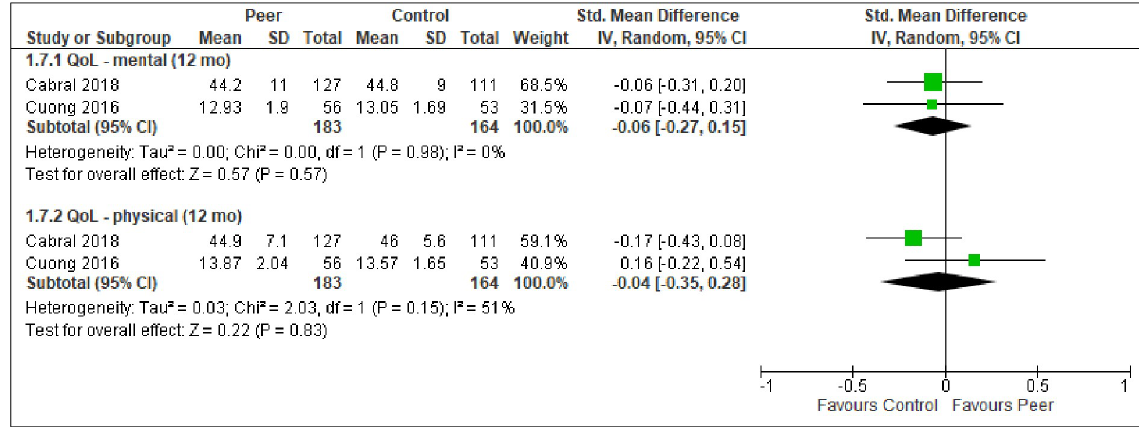
Fig 8. Meta-analyses of outcome quality of life.